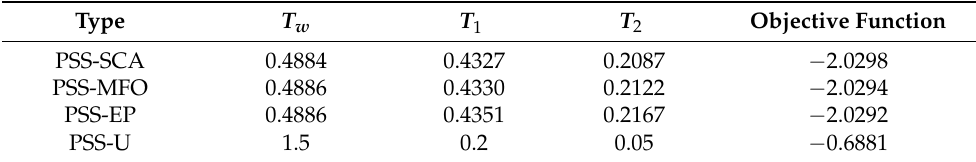
Table 3. Comparison of PSS-SCA, PSS-MFO, PSS-EP, and PSS-U for case 1. Type